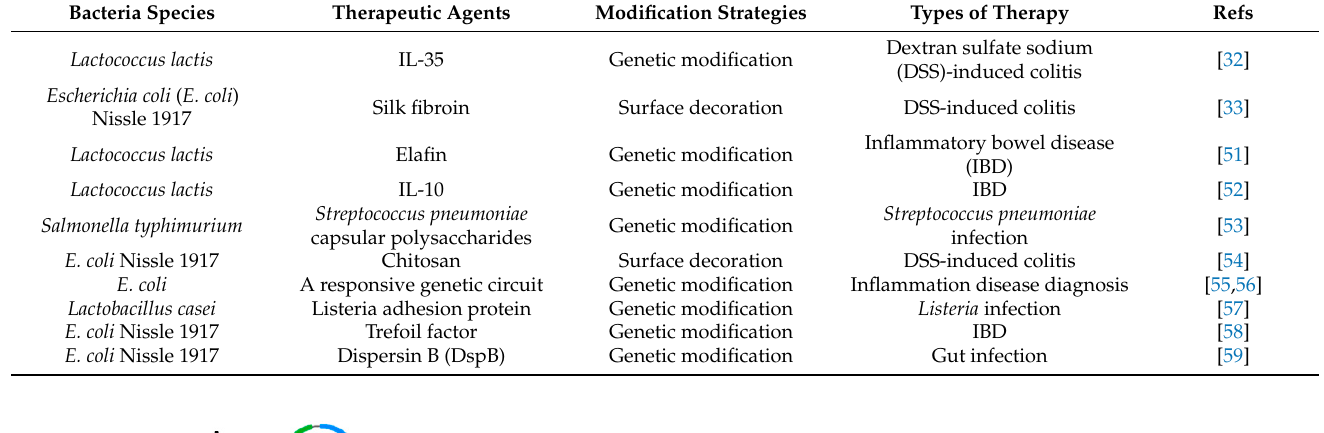
Table 1. Therapeutic biomacromolecules orally delivered by bacteria for treating intestinal infectious diseases. Bacteria Species